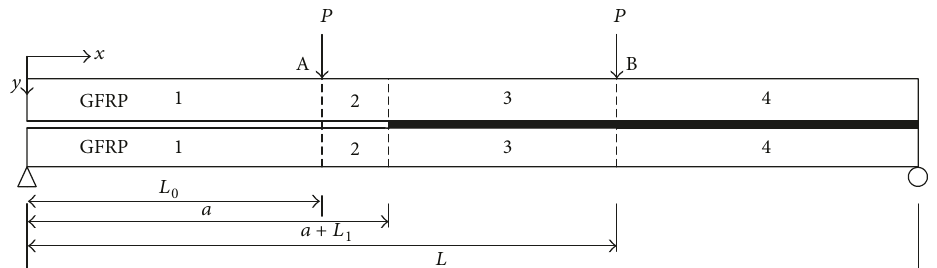
Figure 1: Configuration of the 4-ENF beam.